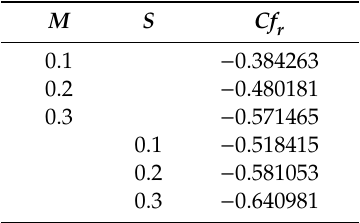
Table 6. The numerical values for surface force w.r.t. di ff erent parameters.